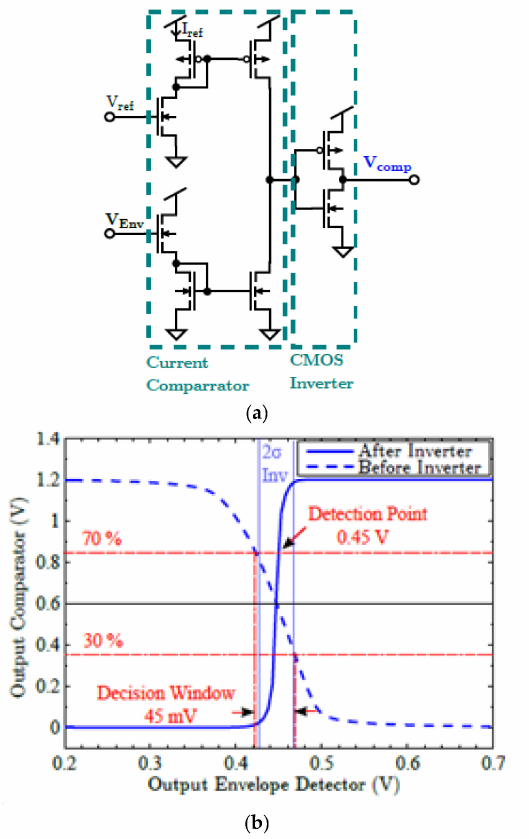
Figure 9. ( a ) Schematic of the current comparator; ( b ) current comparator DC